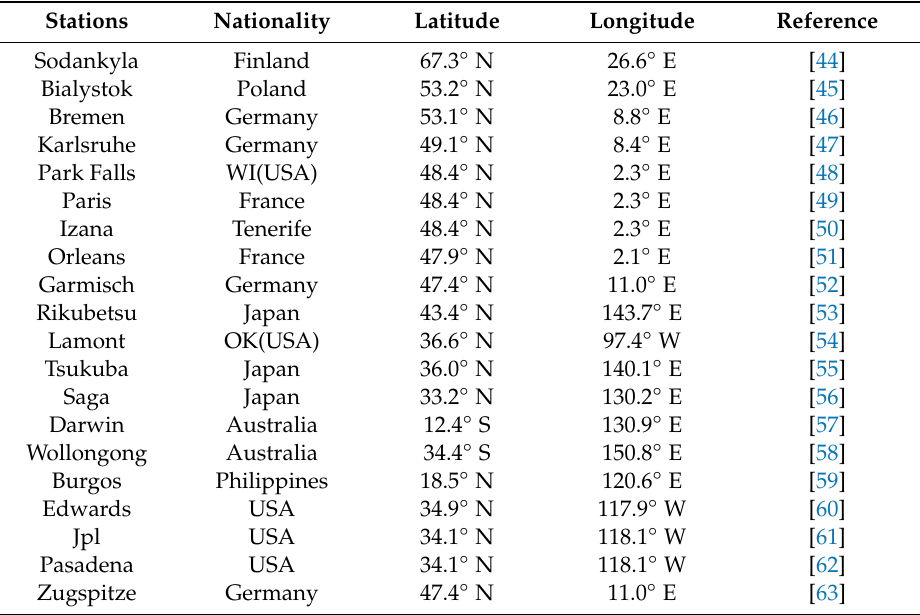
Table 3. Geolocation and reference of each TCCON station used in comparison and validation.